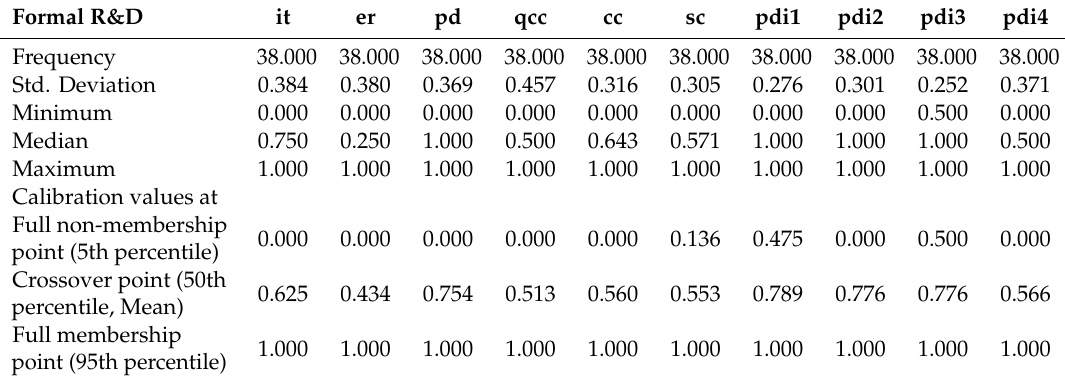
Table 2. Causal conditions and outcome calibration in formal R&D firms.